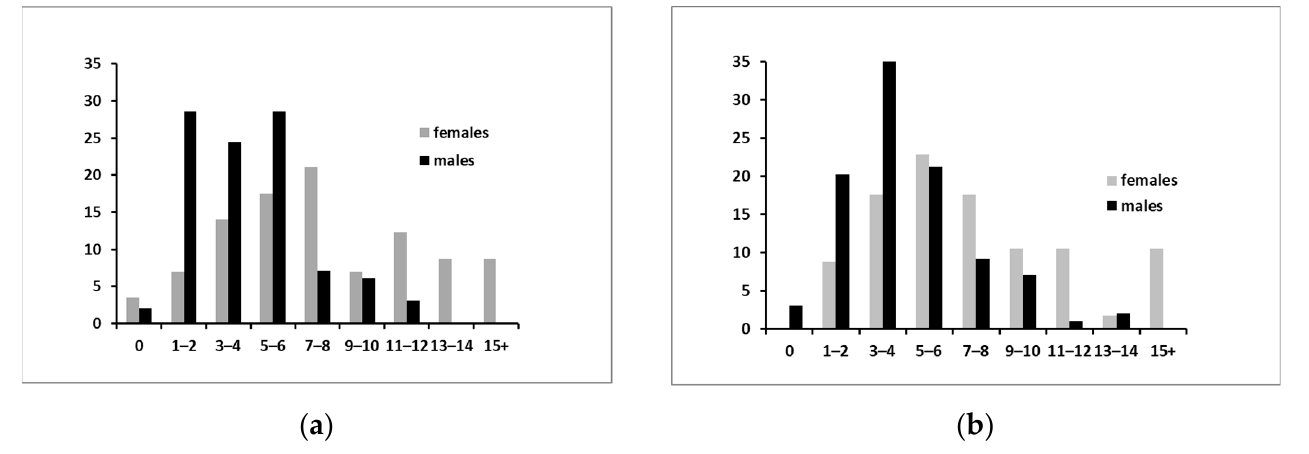
Figure 1. Distribution of the ESS score ( a ) and the PSQI score ( b ) by gender.